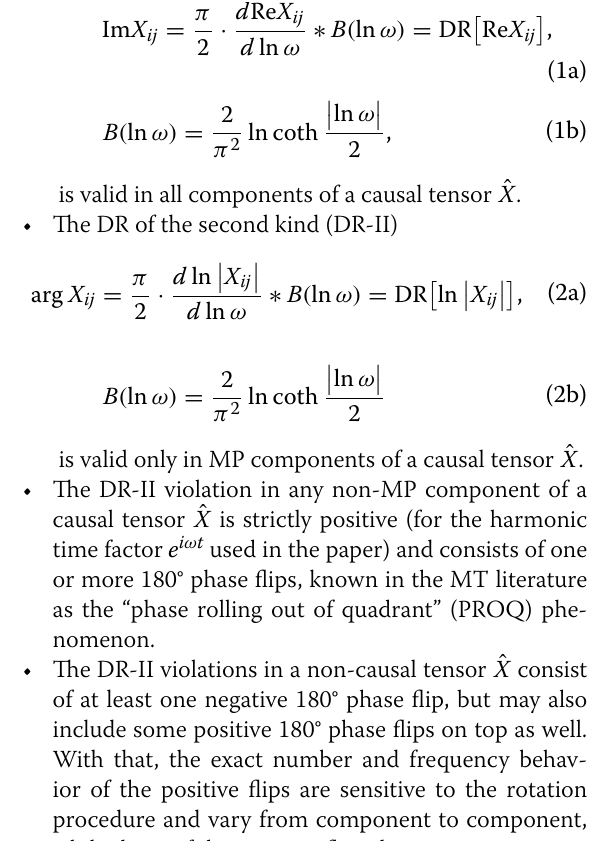
Table 1 Classification of the components of an arbitrary MT tensor X ij component